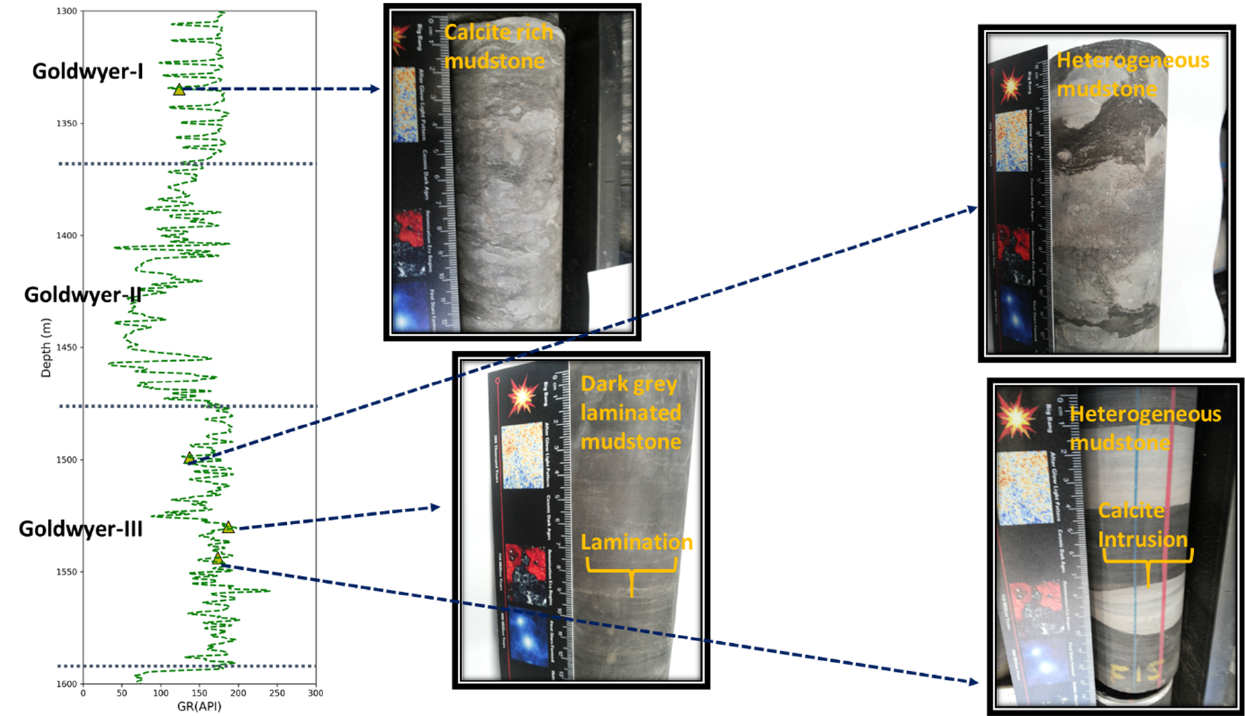
Figure 17. Core images from Theia ‐ 1 well at different depths in the Goldwyer formation of the Canning Basin. Sample depths are shown in GR log by a triangle. Lithological boundaries (black dashed line) are overlaid to show different Goldwyer units. Goldwyer ‐ I and Goldwyer ‐ III units are mostly clay ‐ rich, whereas intermediate Goldwyer ‐ II unit is a car ‐ bonate ‐ rich interval. The first core example is mostly calcite rich mudstone and mostly homogeneous in Goldwyer ‐ I unit. The second core image is a mixture of calcite and mudstone, and is highly heterogeneous. The third and fourth core are dark ‐ grey color mudstone with lamination and highly complex composition of calcite and mudstone, respectively. The depth interval of third and fourth core sample is within 15 m, but a significant change in depositional environment is observed. The organic richness of these core samples varies from 0.04 to 2.25 wt % (from current ongoing research work of [60]).